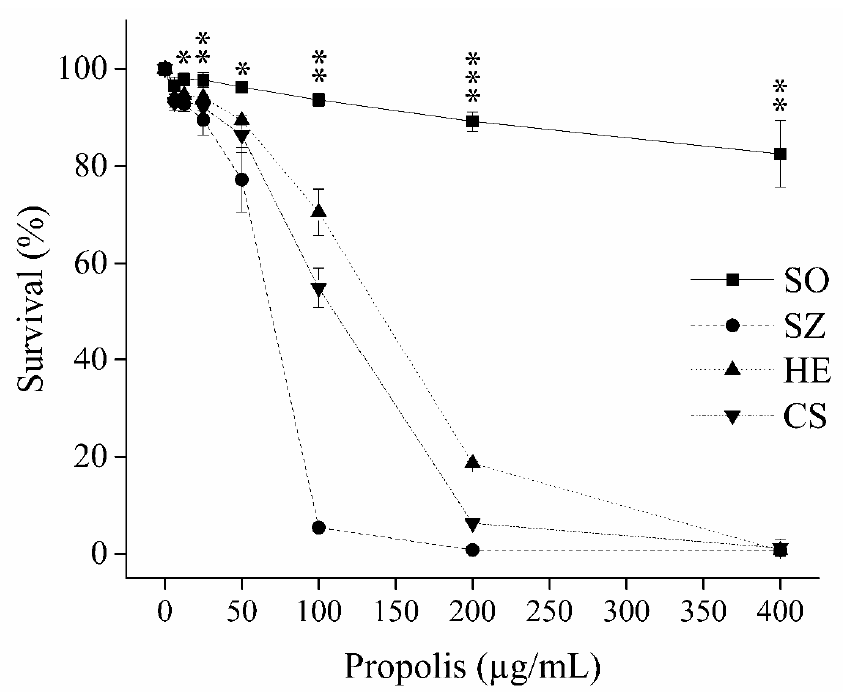
Figure 1. Inhibitory curve. Survival of C. albicans ATCC 44,829 after 48 h of incubation at 35 °C (y-axis), using 0, 6.25, 12.5, 25, 50, 100, 200, and 400 µg/mL of different ethanol extract of propolis (EEP) samples (x-axis) from diverse geographical areas in Hungary: Somogybabod (SO), Szolnok (SZ), Héhalom (HE), and Csikóst ő tt ő s (CS). The treated and control samples contained a final ethanol concentration of 0.8% ( v / v ), and the Student’s t -test was applied to calculate the level of significance between low antifungal activity (SO) and high antifungal activity samples (SZ, HE, and CS). The figure illustrates the lowest level of significance among the low antifungal (SO) and high-antifungal (SZ, HE, and CS) samples. * p < 0.05, ** p < 0.01, and *** p < 0.001. Table 1. Inhibitory data. The minimum inhibitory concentration (MIC) values were determined as the lowest concentration at 80% growth inhibition. The half-maximal inhibitory concentration (IC 50 ) values were also determined using four different ethanol extracts of propolis on C. albicans . The values are expressed in µg/mL. The geographical areas of propolis origin were Somogybabod (SO), Szolnok (SZ), Héhalom (HE), and Csikóst ő tt ő s (CS). EEP (µg/mL) SO